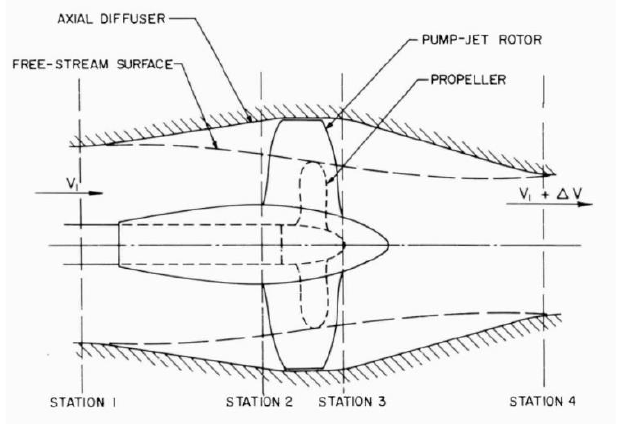
Figure 17. Flow comparison through the pump-jet and propeller [81].